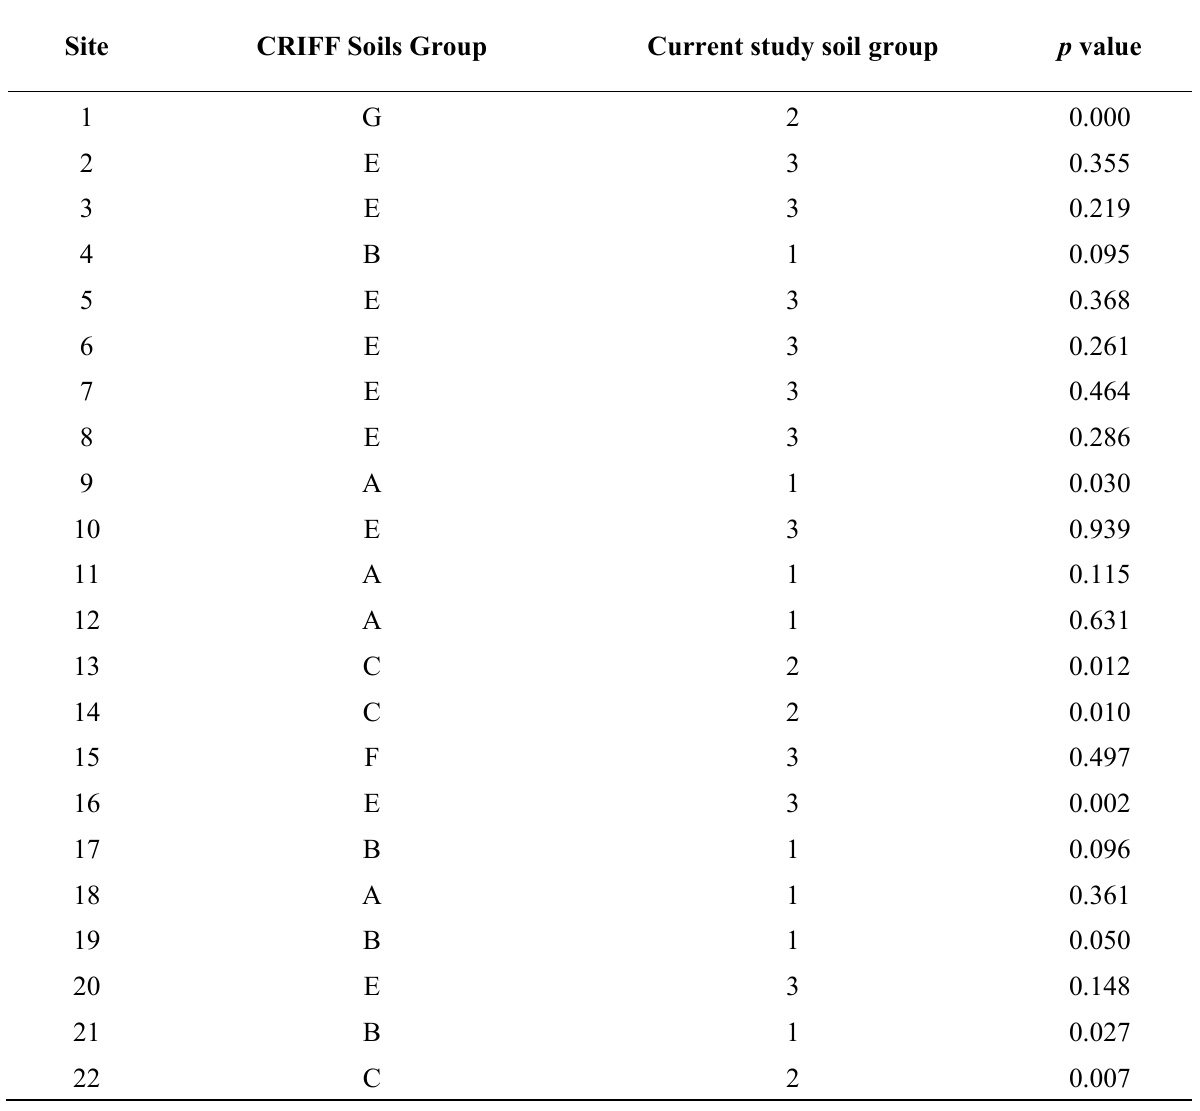
Table 5. Summary of statistical significance ( p values) for annual volume growth eight years after study initiation for the 22 sites where nitrogen and phosphorus were added at different rates and frequencies in Pinus stands in the southeast United